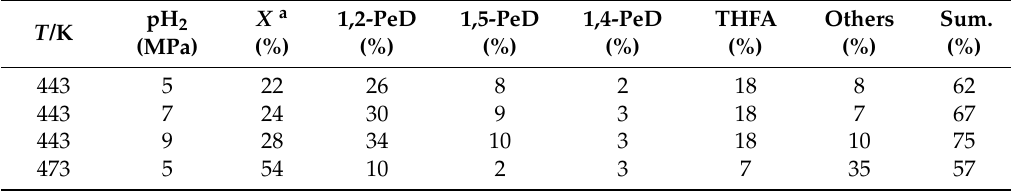
Table 4. Selectivity and conversion under variation of the reaction parameters.